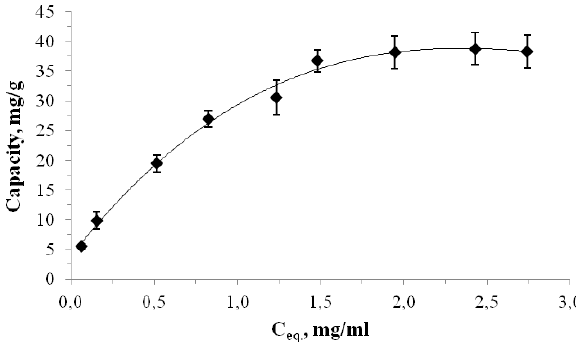
Figure 4: Isotherm of palladium sorption by a humic sorbent.